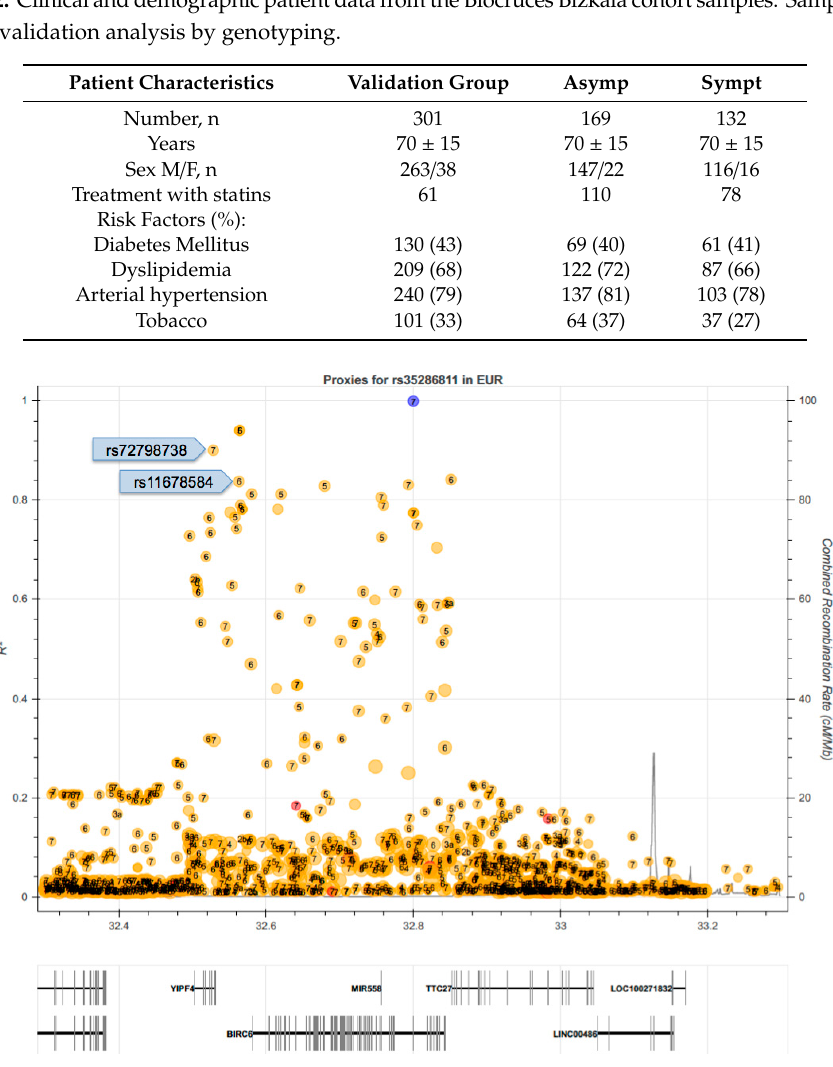
Figure A1. Proxies of rs35286811. Plot represents individual LD r 2 values of SNPs (ochre circles) in the BIRC6 region with rs35286811 (blue circle). GWAS-derived SNPs rs72798738 and rs11678584 are indicated. Regulatory potential of individual SNPs is scored from 1 (high) to 7 (low). Genes located in this interval are depicted in the bottom part of the figure. Image information was produced by means of https://ldlink.nci.nih.gov/.